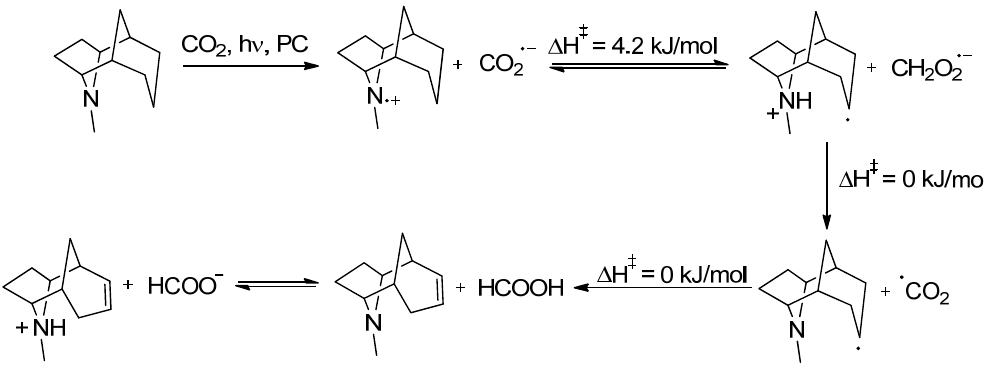
Figure 9. Tricyclic amine structure as recyclable electron donor [123].